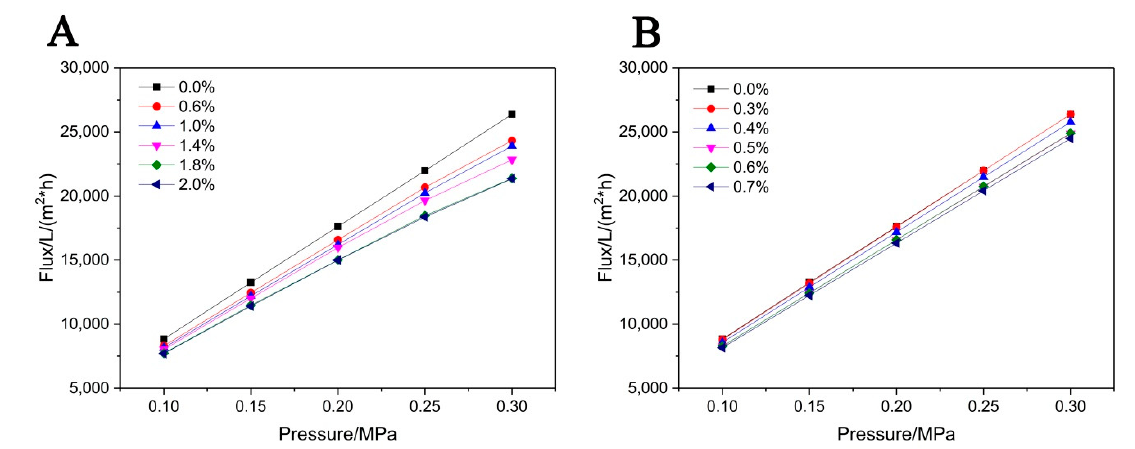
Figure 9. Water permeating flux of the supports with different contents of TiO 2 added by ( A ) in-situ precipitation method and ( B ) in-situ hydrolysis method.